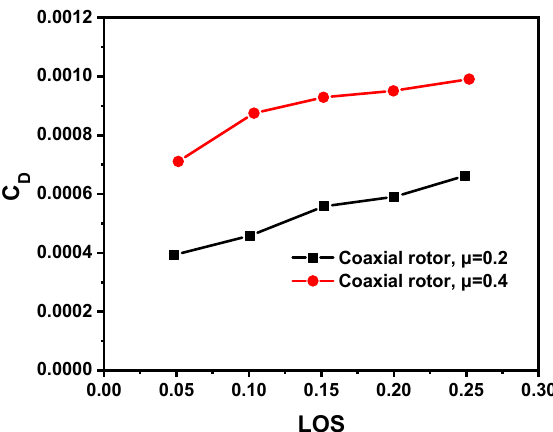
Figure 18. Drag force coefficient (C D ) as a function of the lift offset (LOS).